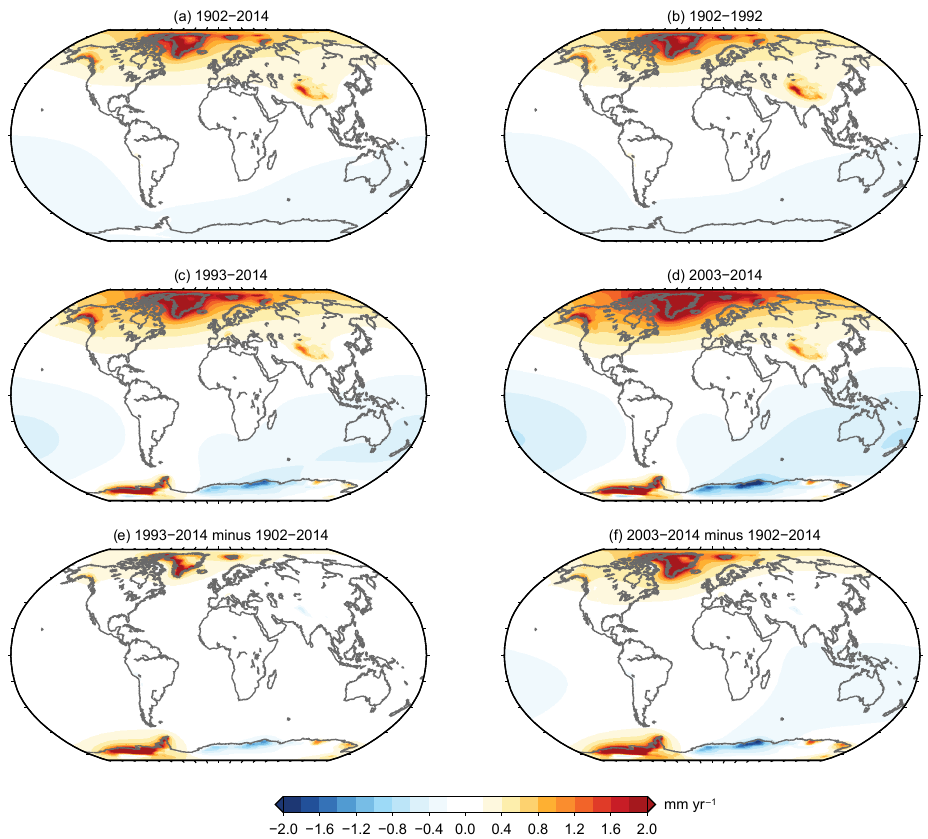
Figure 2. Maps of average vertical deformation rates over different time spans. (a) Full time span covered by this study; (b) pre-satellite era; (c) the GPS era; (e) the GRACE era; (e) panel (c) minus panel (a) ; (f) panel (d) minus panel (a)